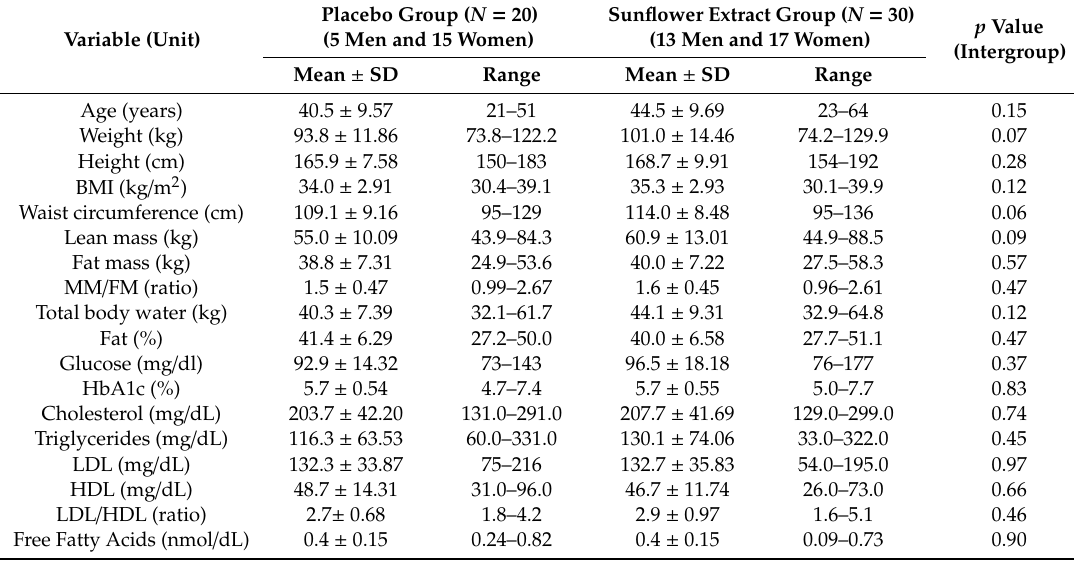
Table 2. Characteristics of the participants at baseline